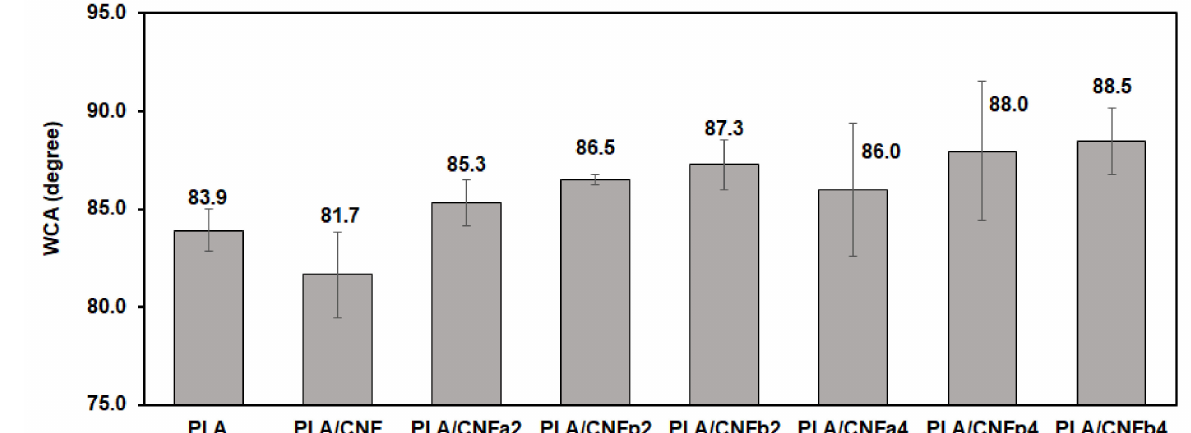
Figure 9. Wettability of the PLA composite